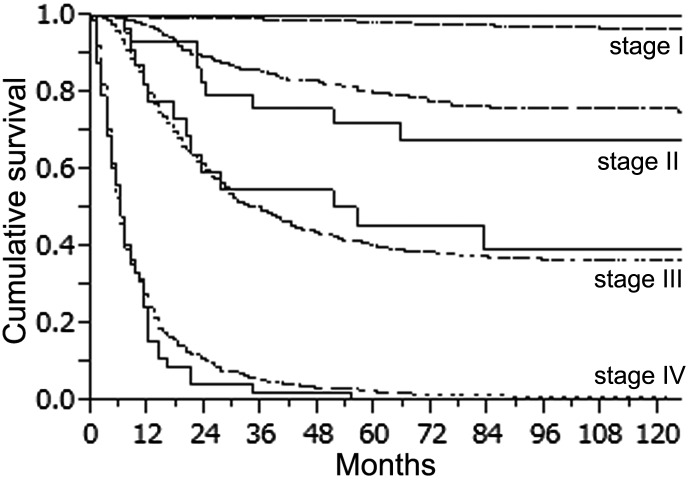
Survival curves according to stage for the younger group (YG, solid line) and the older group (OG, dashed line). The 5-year survival rate of the YG and OG at stage I (100 vs. 97.3%, P=0.181), stage II (68.6 vs. 76.7%, P=0.286) and stage III (36.6 vs. 37.4%, P=0.760). The 2-year survival rate of the YG and OG at stage IV was 4.4 vs. 10.4% (P=0.612).